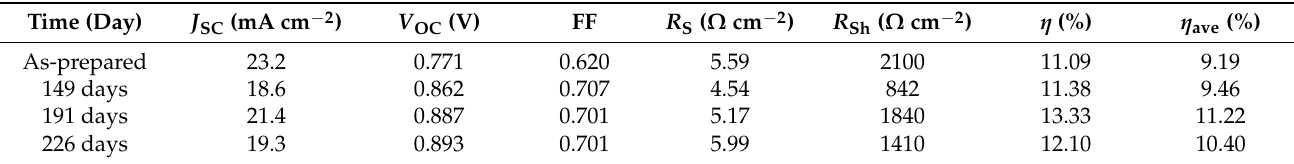
Table 2. Changes of parameters for D × 3